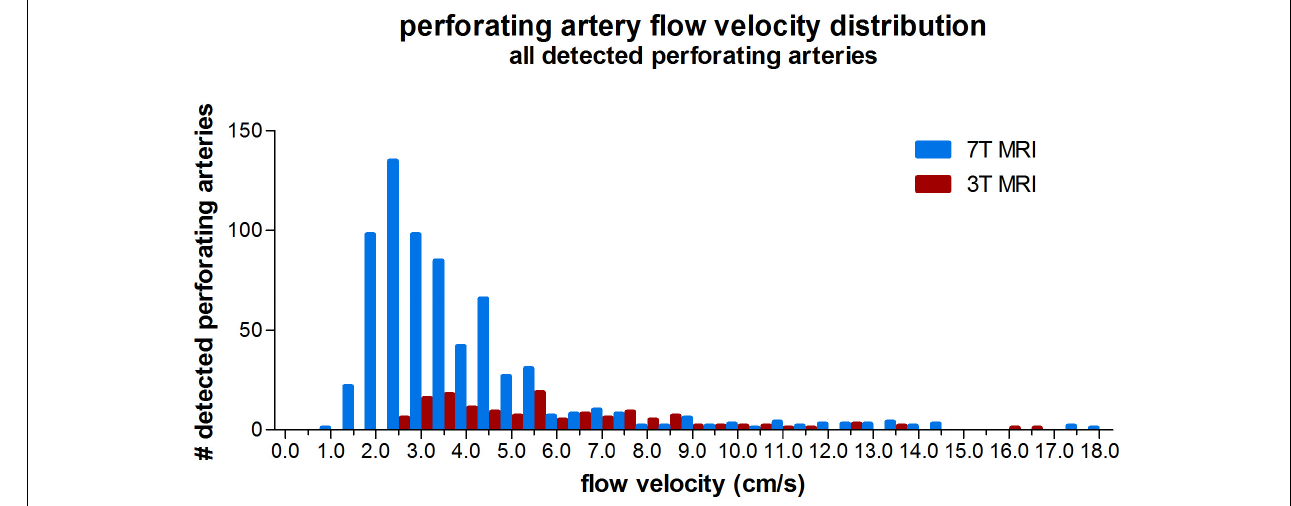
FIGURE 2 | Histogram showing the velocity distribution of all detected perforating arteries on 3 tesla and 7 tesla MRI of all subjects.